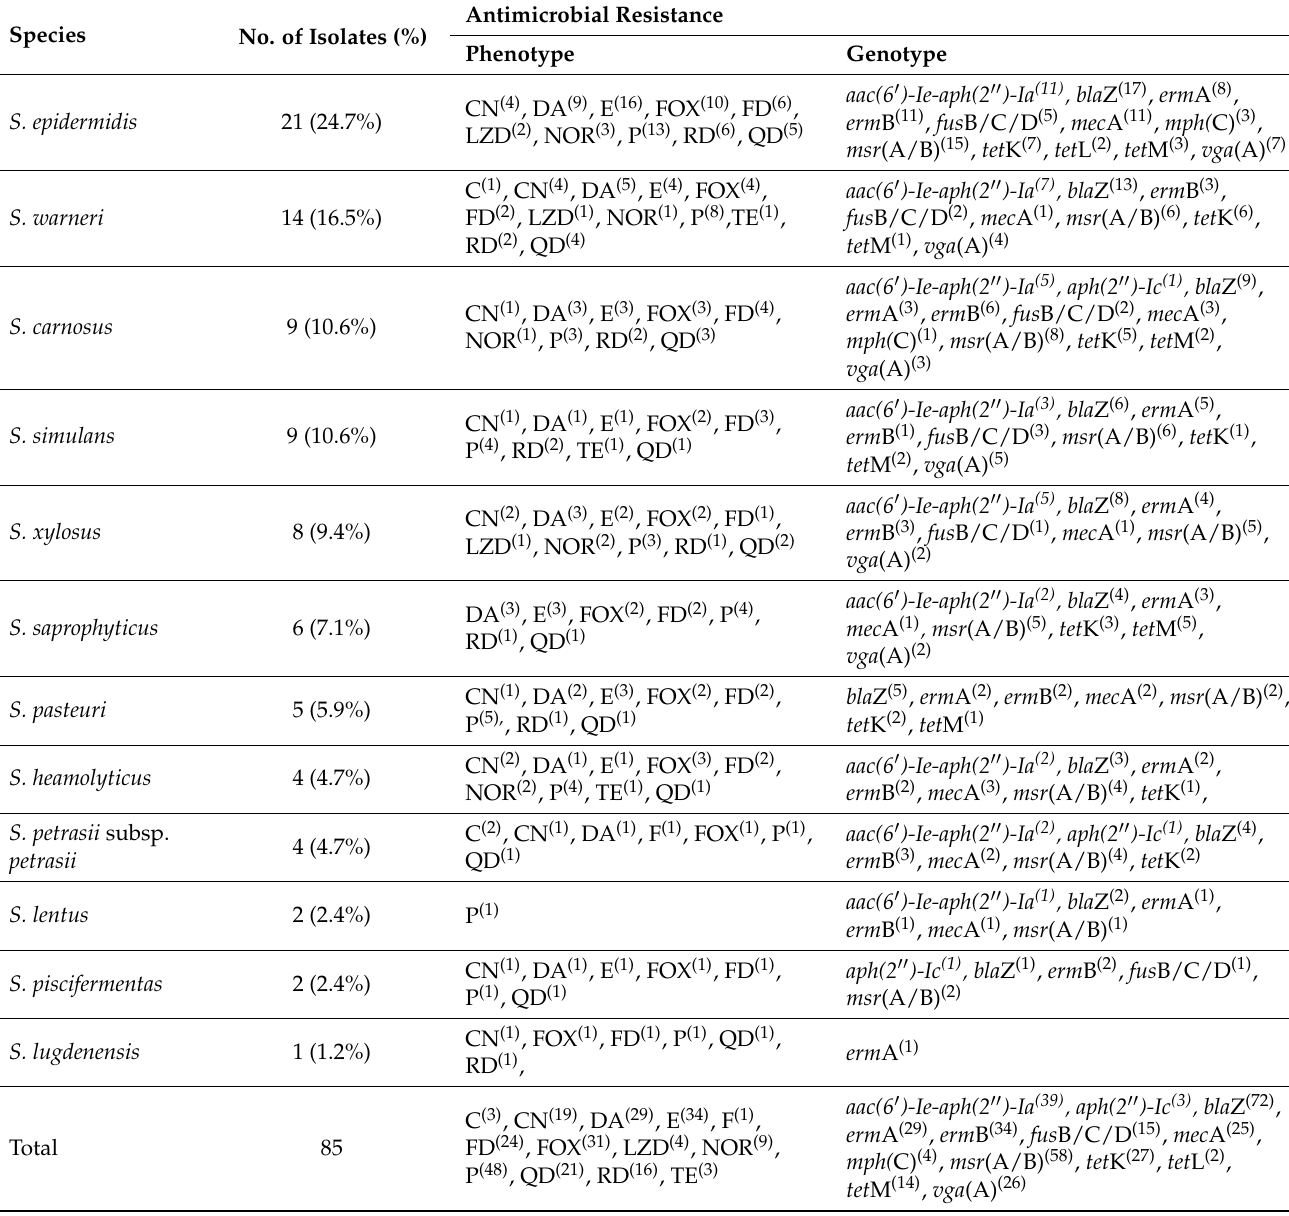
Table 1. Antimicrobial resistance profiles of CoNS isolated from RTE